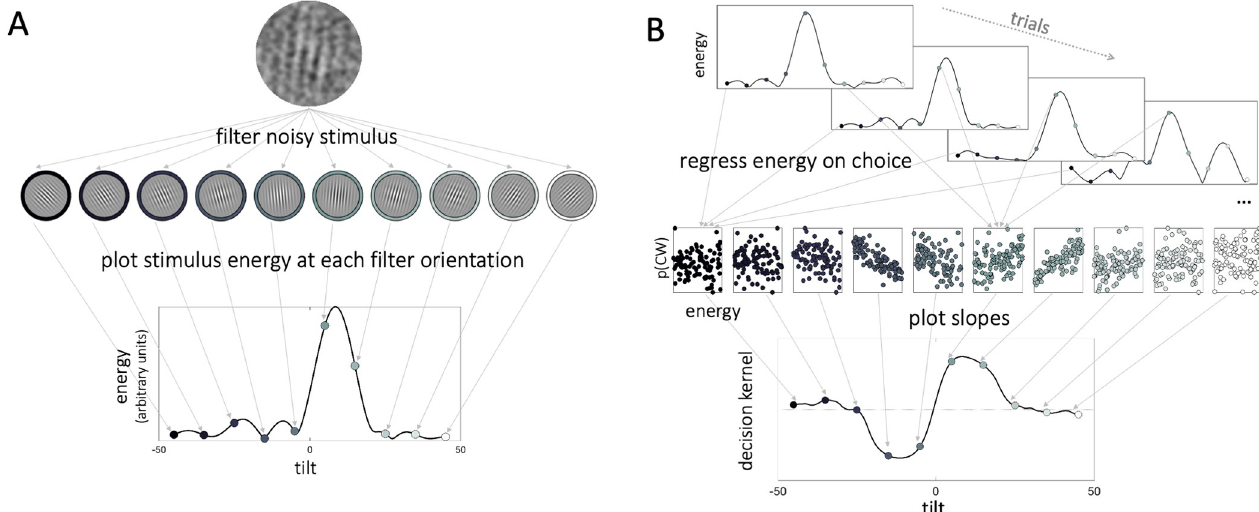
Fig 2. Reverse correlation methods. A : We filtered each noisy stimulus through a pool of oriented Gabor patches to calculate energy across orientation space. The higher the stimulus energy at a given orientation, the more the noisy stimulus resembles a Gabor patch of that orientation. The collection of energies of a given stimulus across orientation space constitutes the energy profile of that stimulus. B : We regressed choices (p(CW)) on z-scored stimulus energy via separate binomial regressions in each orientation bin. The resulting beta coefficients make up the decision kernel. Thus, the decision kernel indexes the relationship between energy at a given orientation and choice. Positive kernel values suggest that the more a stimulus resembles a Gabor patch of that orientation, the more likely is a participant to make a clockwise choice.